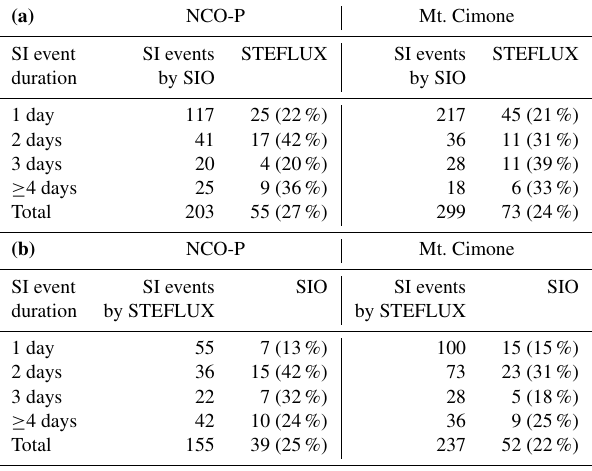
Table 3. (a) SIO vs. STEFLUX: agreement between STEFLUX and the measured SI events (SIO). (b) STEFLUX vs. SIO: agreement between the measured and the modeled (by using STEFLUX) SI events, as a function of the different length of the SI